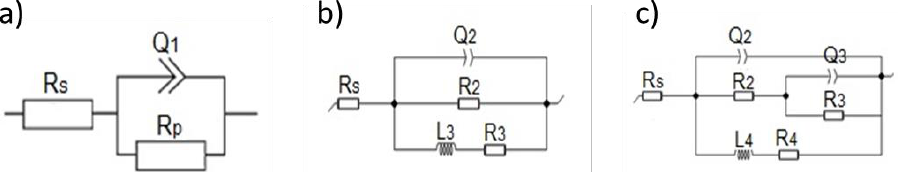
Figure 4. Equivalent circuits used for the Nyquist plot evaluation: ( a ) simplified Randles circuit; ( b ) equivalent circuit with one capacitance and one inductive loop; ( c ) equivalent circuit with two capacitances and one inductive loop.